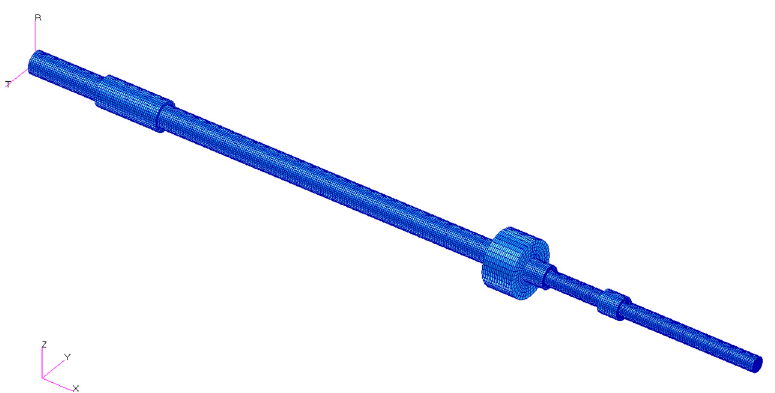
Figure 6. Discretized shaft.